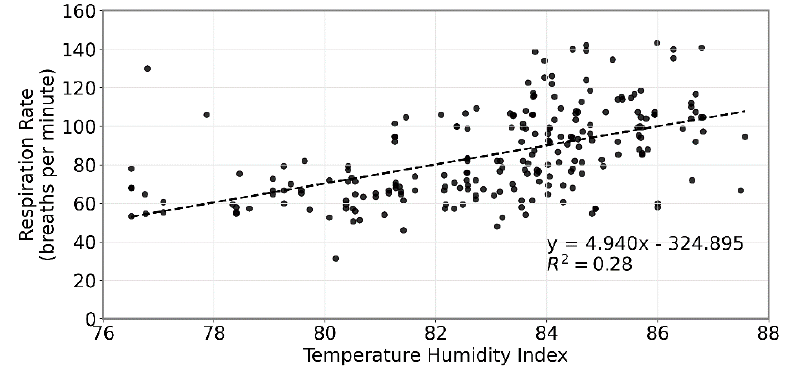
Figure 7. Respiration Rate (RR) variation with Temperature Humidity Index (THI).